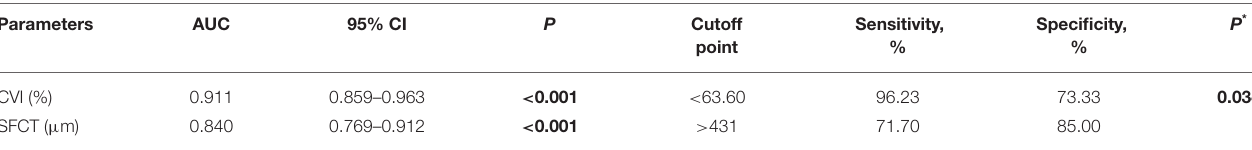
TABLE 4 | Receiver operating characteristic (ROC) curves of the choroidal vascularity index (CVI) and the subfoveal choroidal thickness (SFCT) parameters to discriminate eyes with MG from control eyes with PACG. Parameters